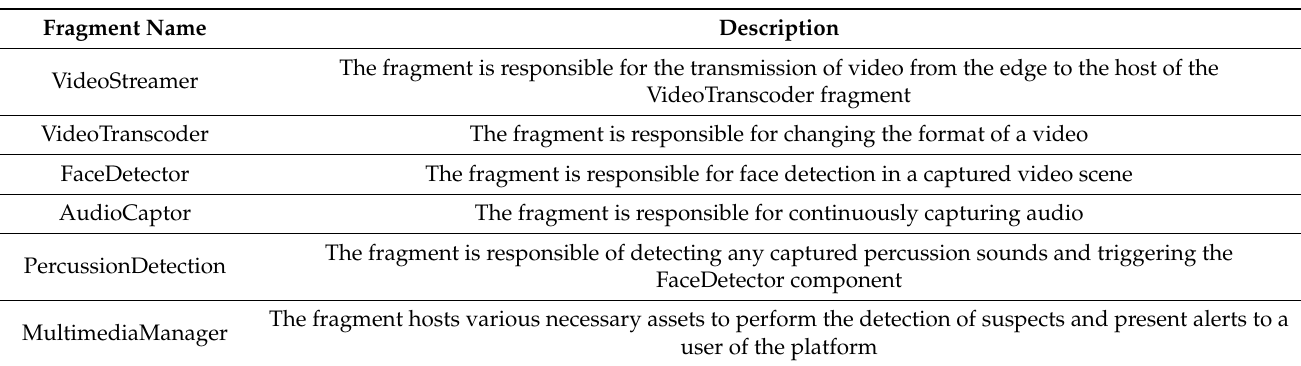
Table 1. Fog surveillance application